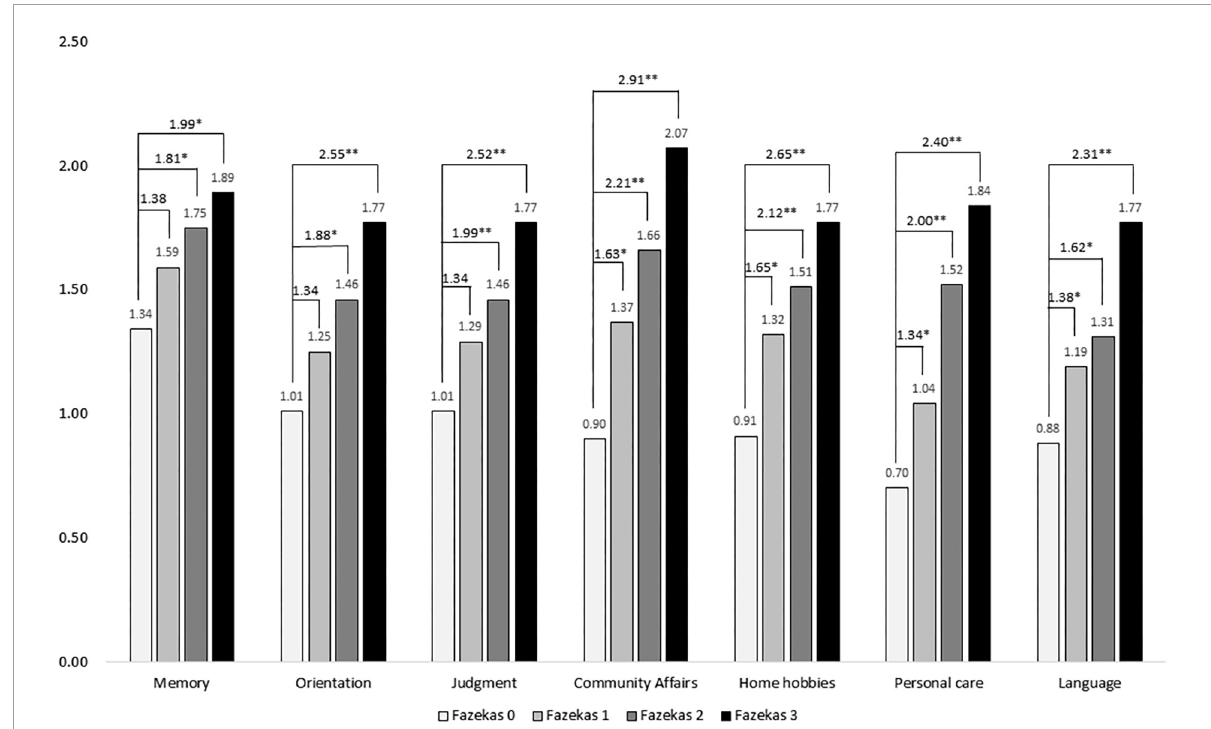
FIGURE1 Comparison of scores of boxes of the Clinical Dementia Rating (CDR-SB) among different Fazekas groups adjusted for age, sex, education, and disease duration. ORs were compared to Fazekas score of 0. ∗ p < 0.05; ∗∗ p < 0.001.